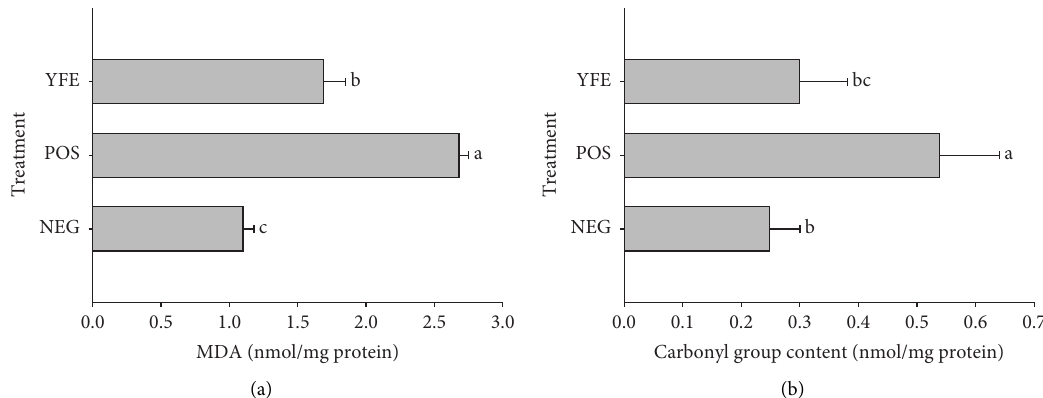
Figure 6: Effect of YFE pretreatment on lipid (a) and protein oxidation (b) of Caco-2 cells under the oxidation stresses induced by H